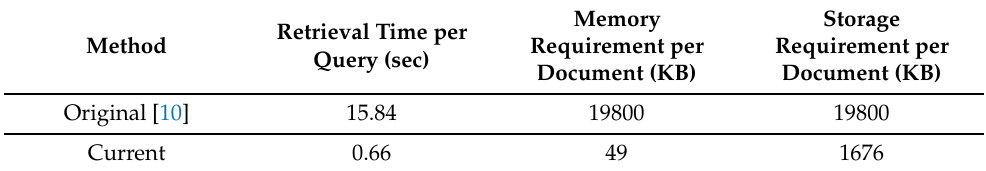
Table 2. Time, memory and storage requirements.